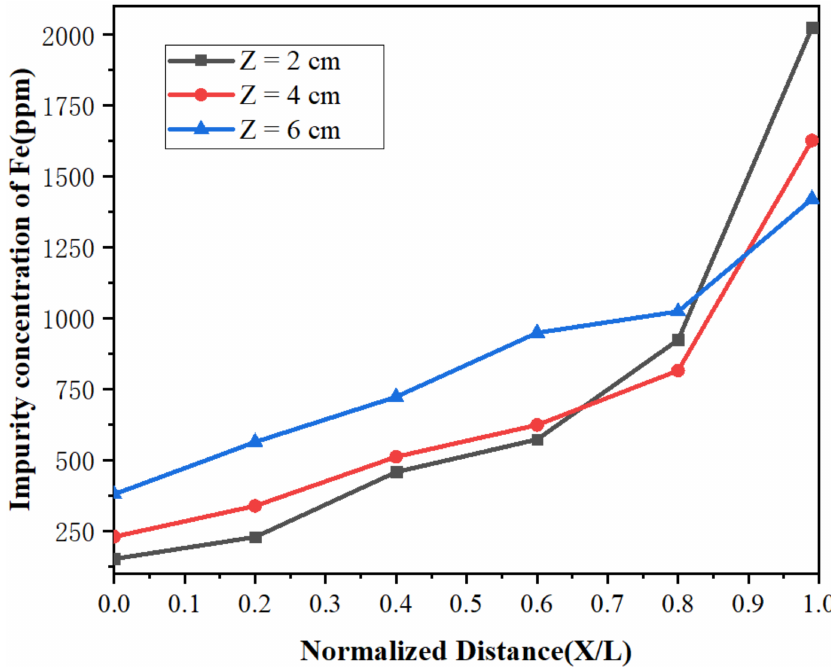
Figure 10. Distribution of Fe under different widths of molten region.